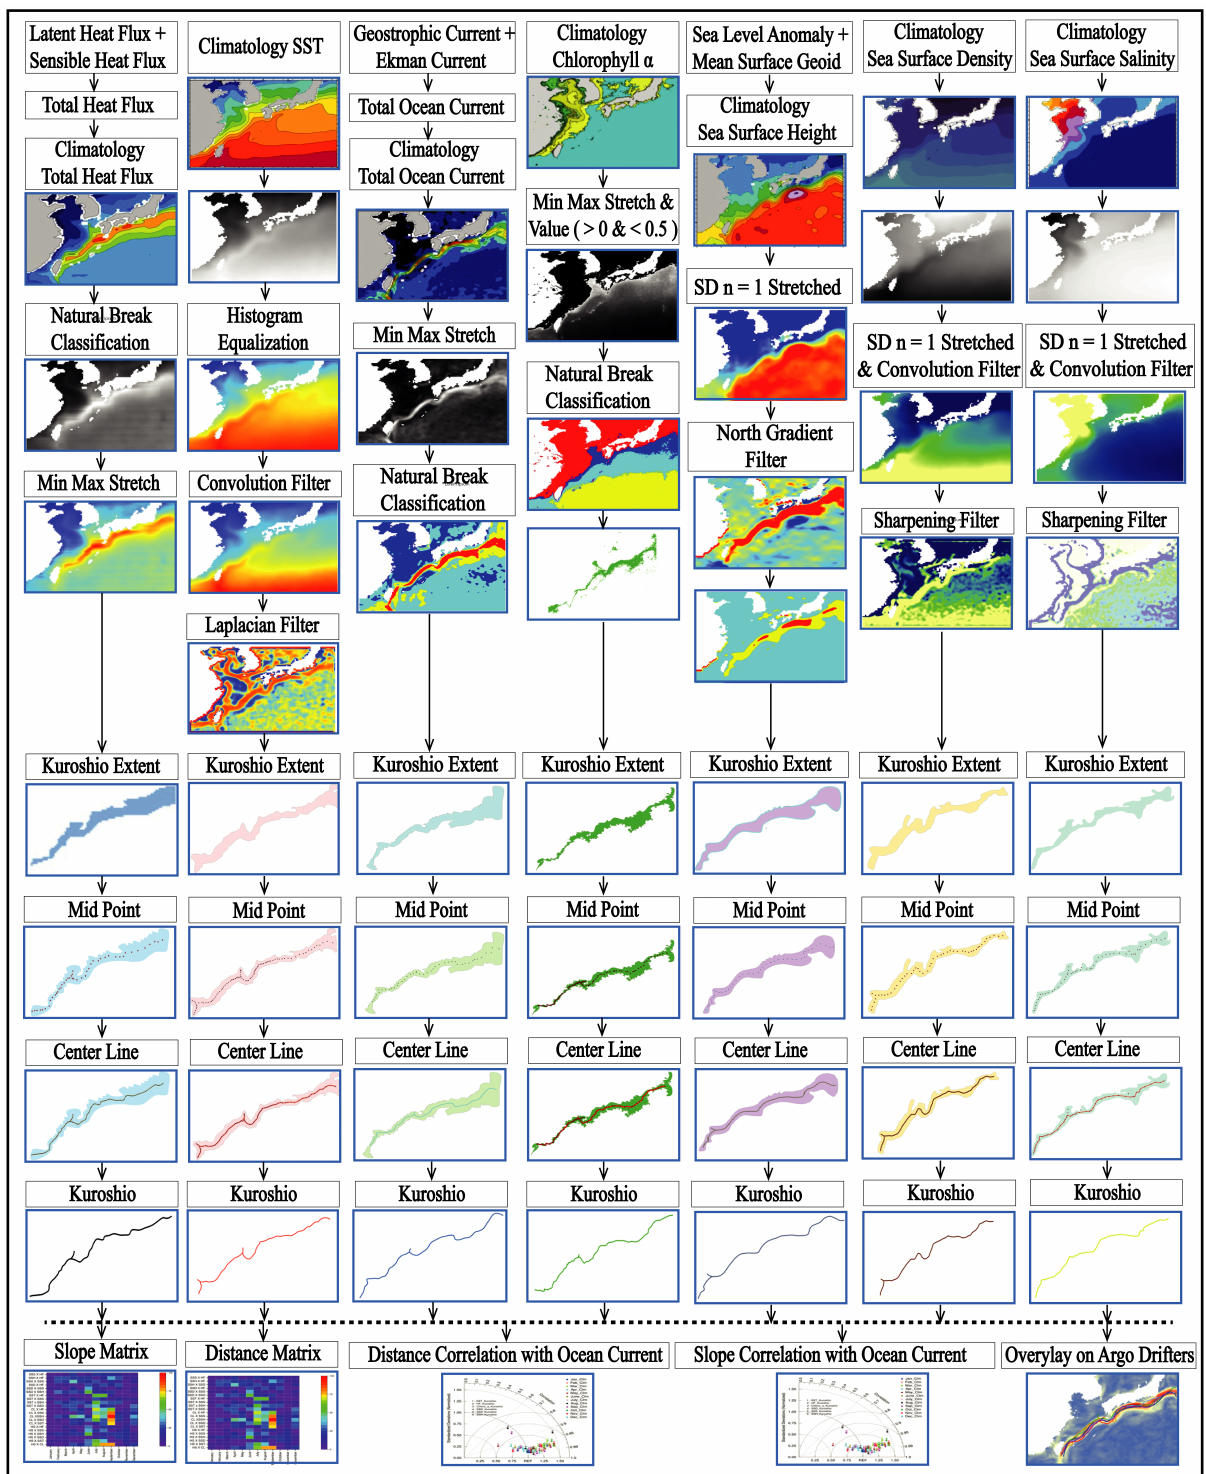
Figure 2. Methodology explaining the sequence of spatial filters and data analysis applied for each data set with their respective